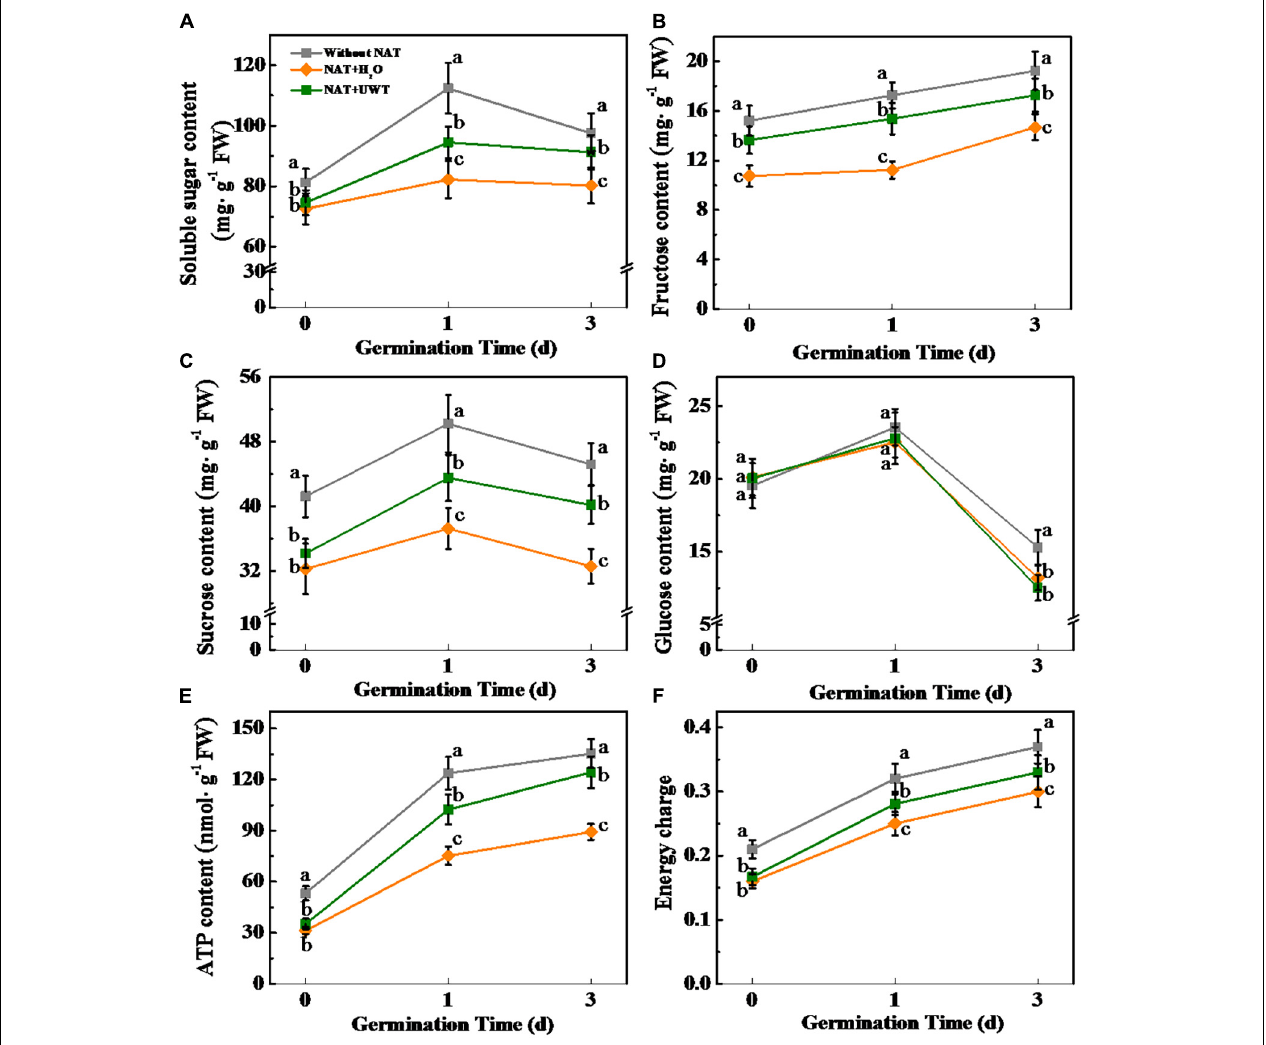
FIGURE 6 | Ultrasonic waves treatment increased the contents of soluble sugar (A) , fructose (B) , sucrose (C) , Glucose (D) , ATP (E) , and energy charge (F) of aged soybean seeds during early germination. Without NAT, fresh seeds without naturally aging treatment (NAT); NAT + H 2 O, Seeds stored for 12 months with H 2 O; NAT + UWT, NAT seeds with UWT. Different lowercase letters in the same column indicate significant differences between different treatments ( p <